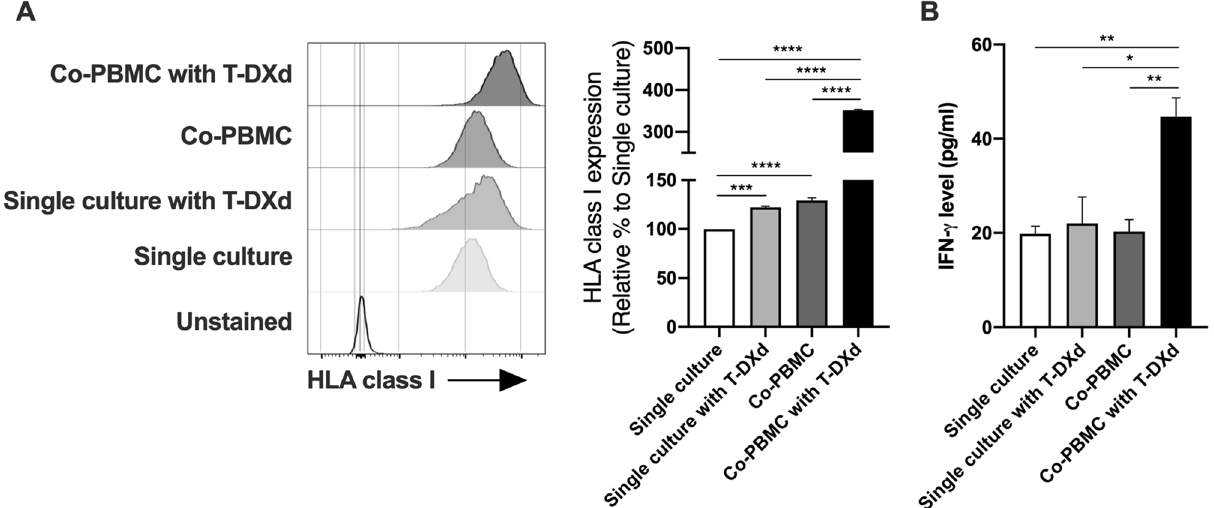
Figure 5. The effect of T-DXd on the expression of HLA class I in HER2-positive GC cells co-cultured with PBMC. ( A ) The expression of HLA class I in NCI-N87 cells co-cultured with or without PBMC in the absence or presence of 1 μg/ml T-DXd for 72 h (n = 3). Single culture, single culture of NCI-N87 cells; Co-PBMC, NCI-N87 cells co-cultured with PBMC. Representative histograms were shown. ( B ) IFN-γ production